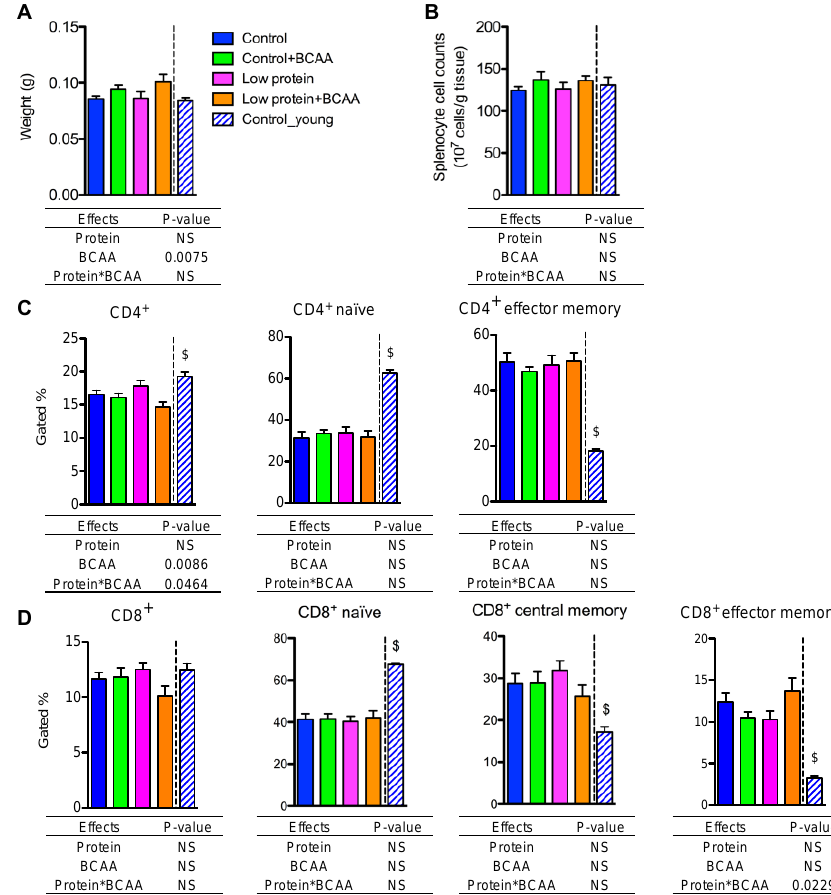
Figure 7. BCAA supplementation increased spleen weight, while dietary intervention had no impact on splenocyte cell counts and the percentages of naive and memory T lymphocytes in spleen. Spleen weight was recorded ( A ), and splenocyte cell counts were calculated ( B ). The quantification of CD4 + , and the naïve (CD4 + CD62L + CD44 − ) and memory (CD4 + CD62L − CD44 + ) CD4 + subpopulations in spleen ( C ). The quantification of CD8 + , and the naïve (CD8 + CD62L + CD44 − ), central memory (CD8 + CD62L + CD44 + ), and effector memory (CD8 + CD62L − CD44 + ) CD8 + subpopulations in spleen ( D ). Data represent mean ± SEM ( n = 11–12 mice/group). Statistical analyses of main effects (protein and BCAA) and interactions (protein*BCAA) are shown below each graph. $ p < 0.05 for the young vs. old control groups.